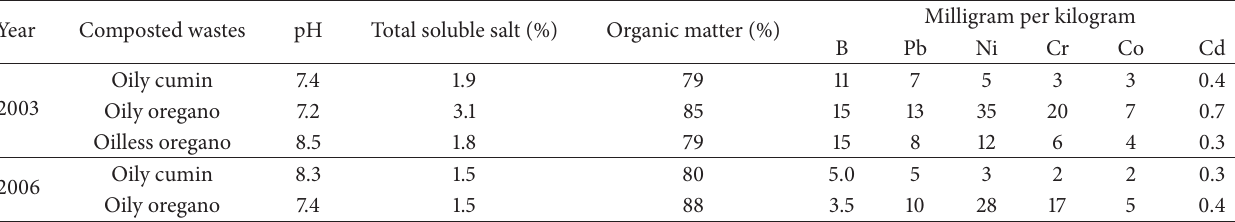
Table 1: Chemical properties of composted wastes used in two field experiments.